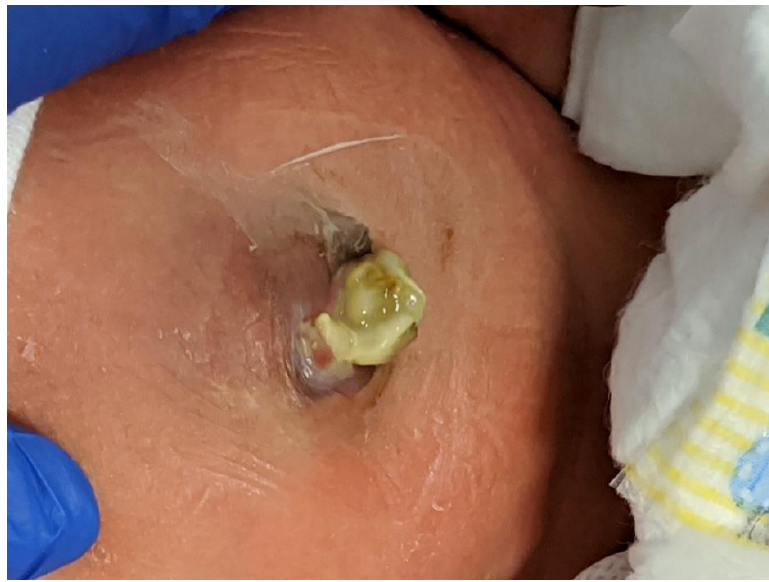
Figure 4. The infant shown in Figure 1 underwent a primary sutureless closure soon after birth. Shown at 19 days of age, he is on full oral feeds.